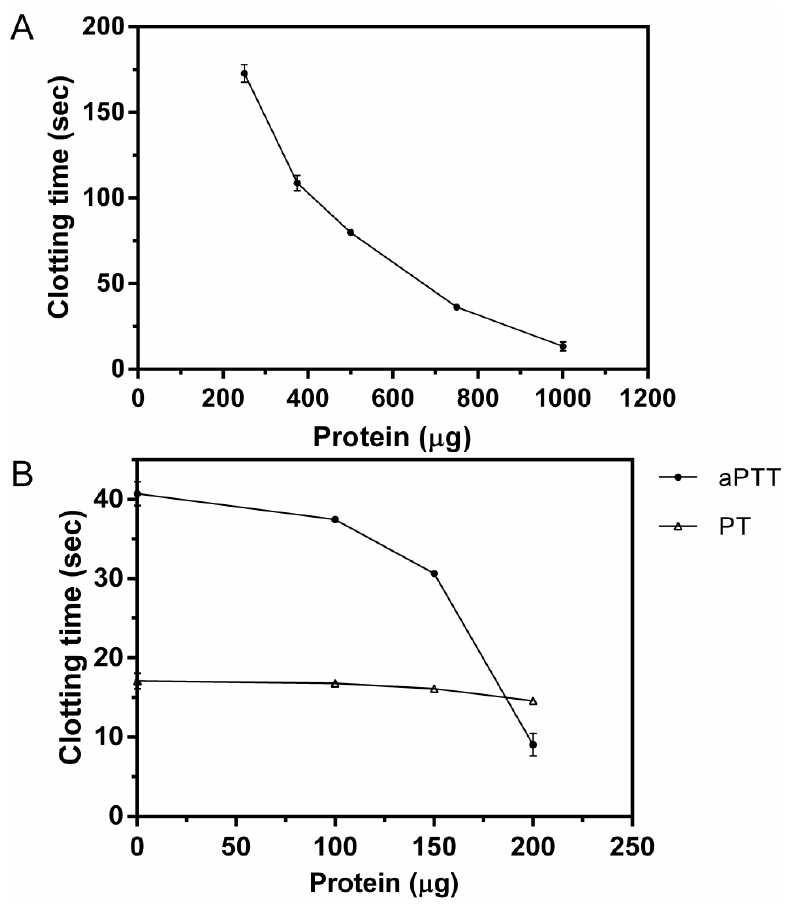
Figure 5. Effect of C. urens fraction F1.0 on clotting time of human plasma. (A) Detection of coagulant activity. The fraction F1.0 of C. urens (ranging from 250–1000 µg) was incubated with 150 µL of human plasma and the time for clot formation was recorded. (B) Effect of C. urens fraction F1.0 on the activated partial thromboplastin time (APTT) and prothrombin time (PT). C. urens fraction F1.0 proteins ranging from 100–200 µg were preincubated with 60 µL of human plasma for 1 min at 37 °C and the time for clot formation was recorded. The values represent mean ± SEM ( n =